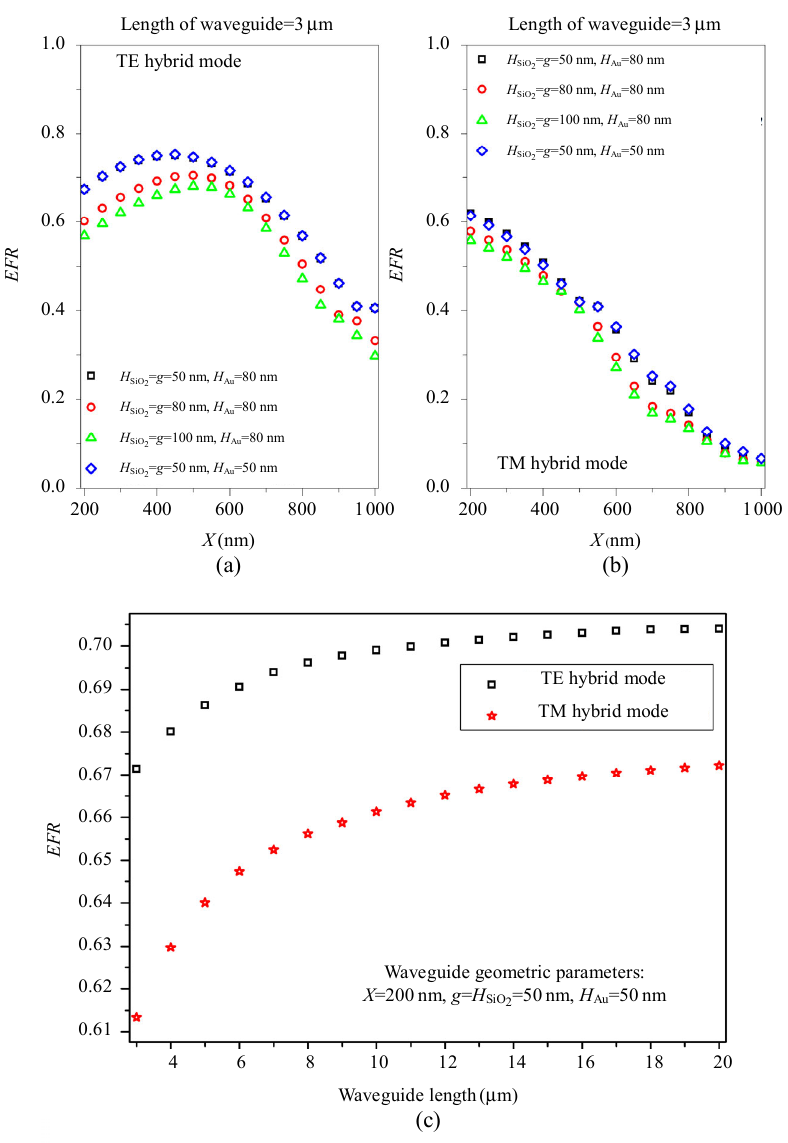
Fig. 7 EFR versus WG geometry at the fixed WG length: (a) TE hybrid mode, (b) TM hybrid mode, and (c) EFR versus WG length at fixed geometric parameters, i.e., X =200 nm and g= H SiO